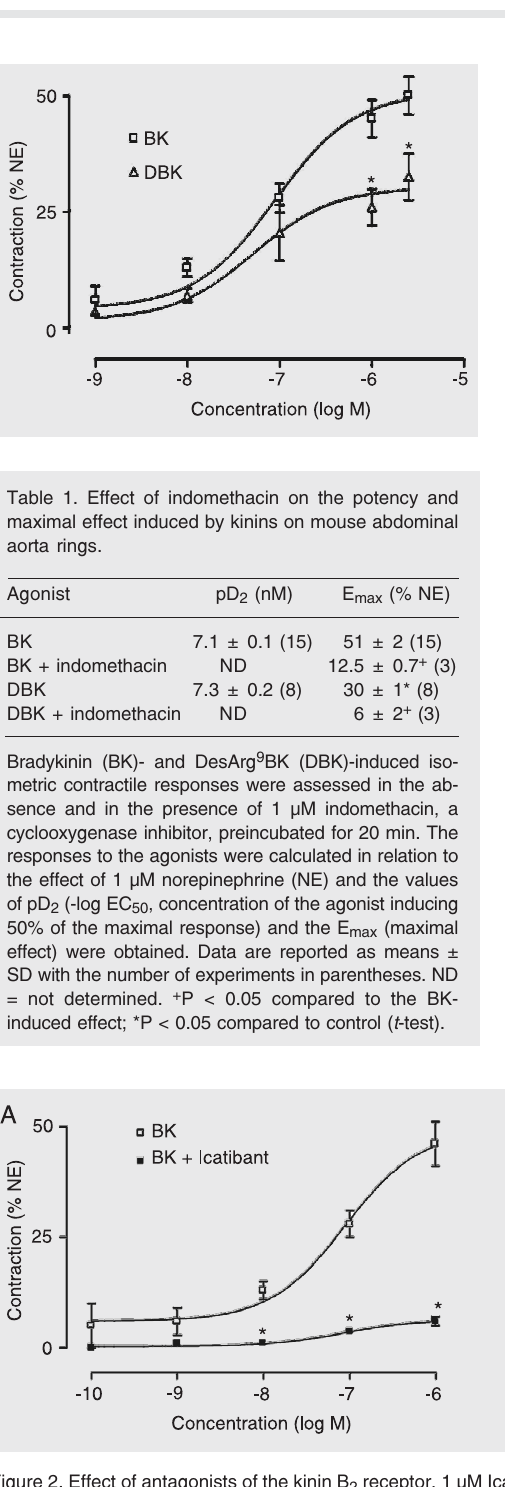
Figure 2. Effect of antagonists of the kinin B 2 receptor, 1 µM Icatibant and of the B 1 receptor, 1 µM R-715, on abdominal aortic rings isolated from mice. Cumulative concentration-response curves for bradykinin (BK) (A) and Des-Arg 9 BK (DBK) (B) were determined in the presence and absence of the respective antagonists. The isometric contraction responses were calculated in relation to the maximal effect of 1 µM norepinephrine (NE) which was considered to be 100%. Data are reported as the means ± SD of 5 experiments. *P < 0.05 compared to